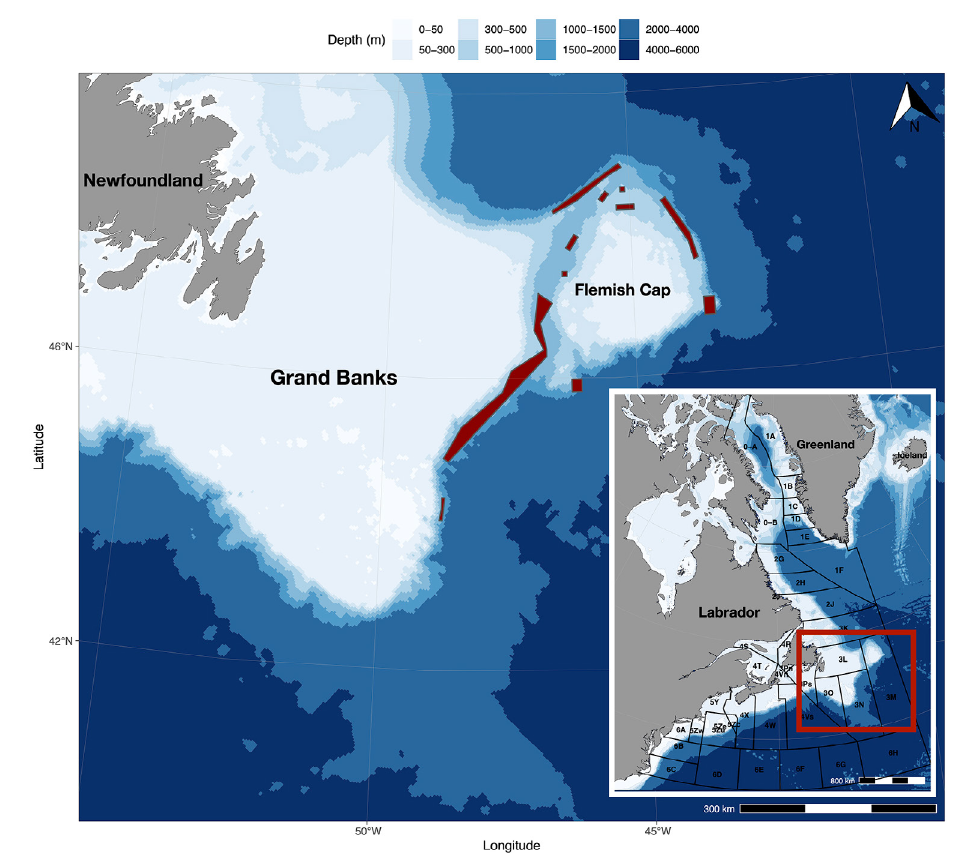
Fig. 1. – Map of the location of Flemish Cap in the Northwest Atlantic. Lines indicated isobath depth. The inset shows in detail the area of the red square: straight lines and codes indicate Northwest Atlantic Fisheries Organization (NAFO) management divisions around the Flemish Cap (3M). Red polygons indicate sponge closure